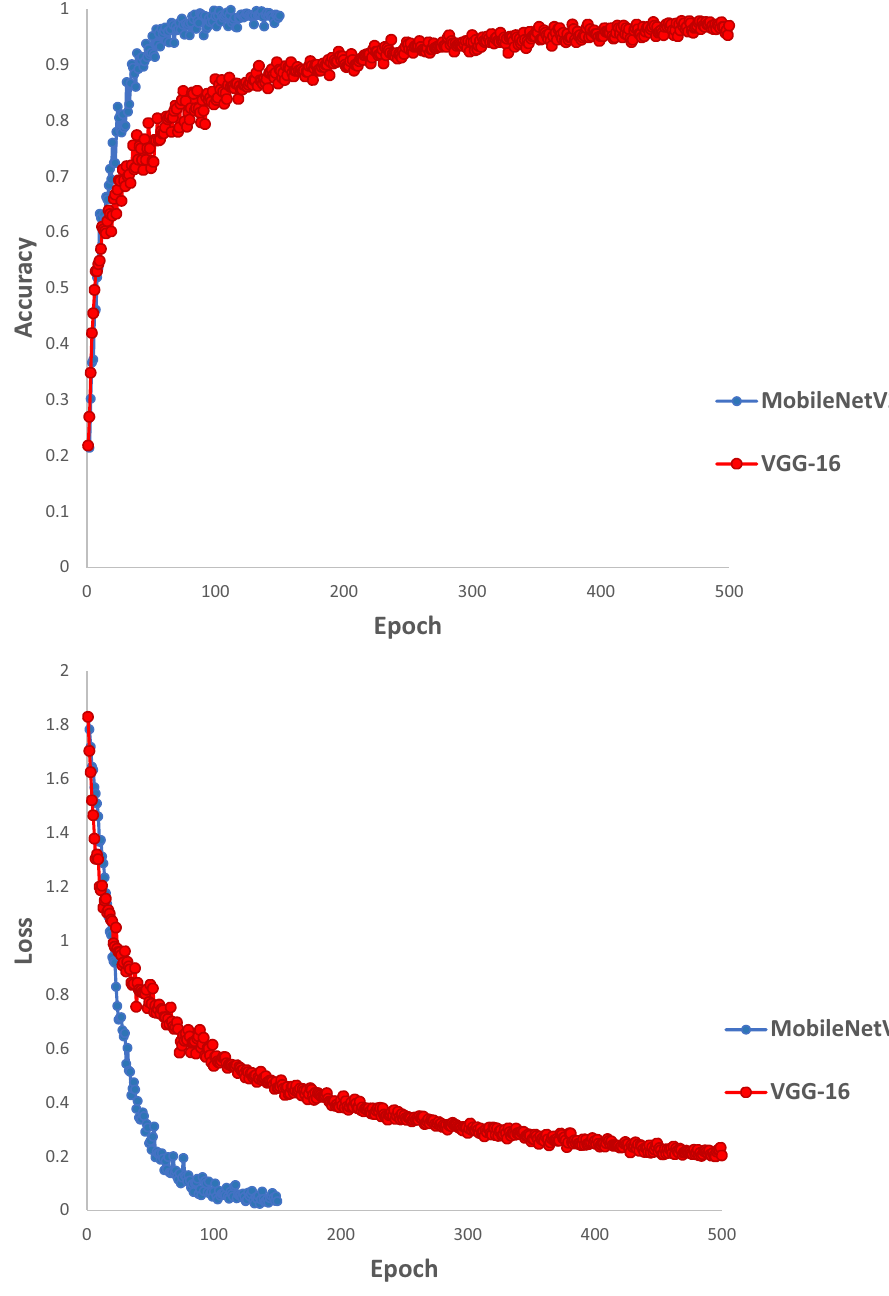
Figure 5. Accuracy and loss values of MobileNetV2 and VGG-16 model with an initial weight from ImageNet during the training